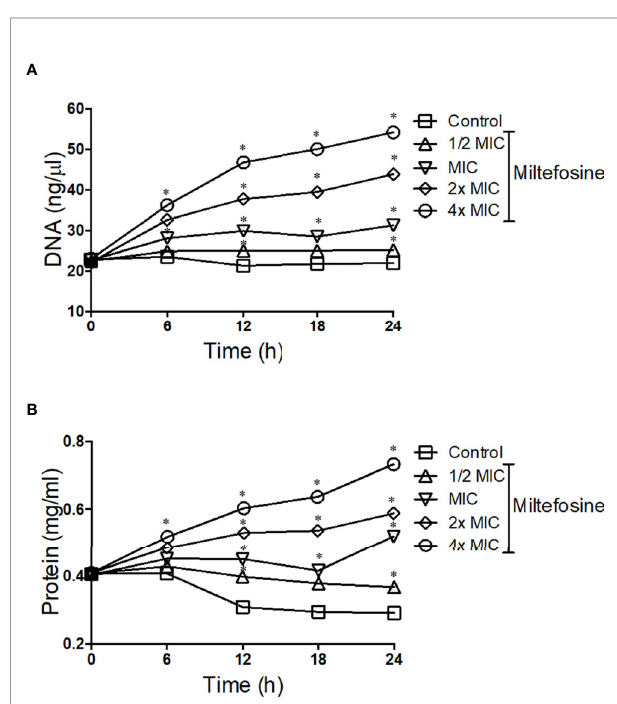
FIGURE 9 | The kinetics of DNA (A) and protein (B) release by Scedosporium aurantiacum cells in the presence of different concentrations of miltefosine. S. aurantiacum cells were centrifuged after 0, 6, 12, 18 and 24 h of growth, and DNA and protein content were measured in the supernatant using NanoDrop (Thermo Fisher Scienti fi c). * p <